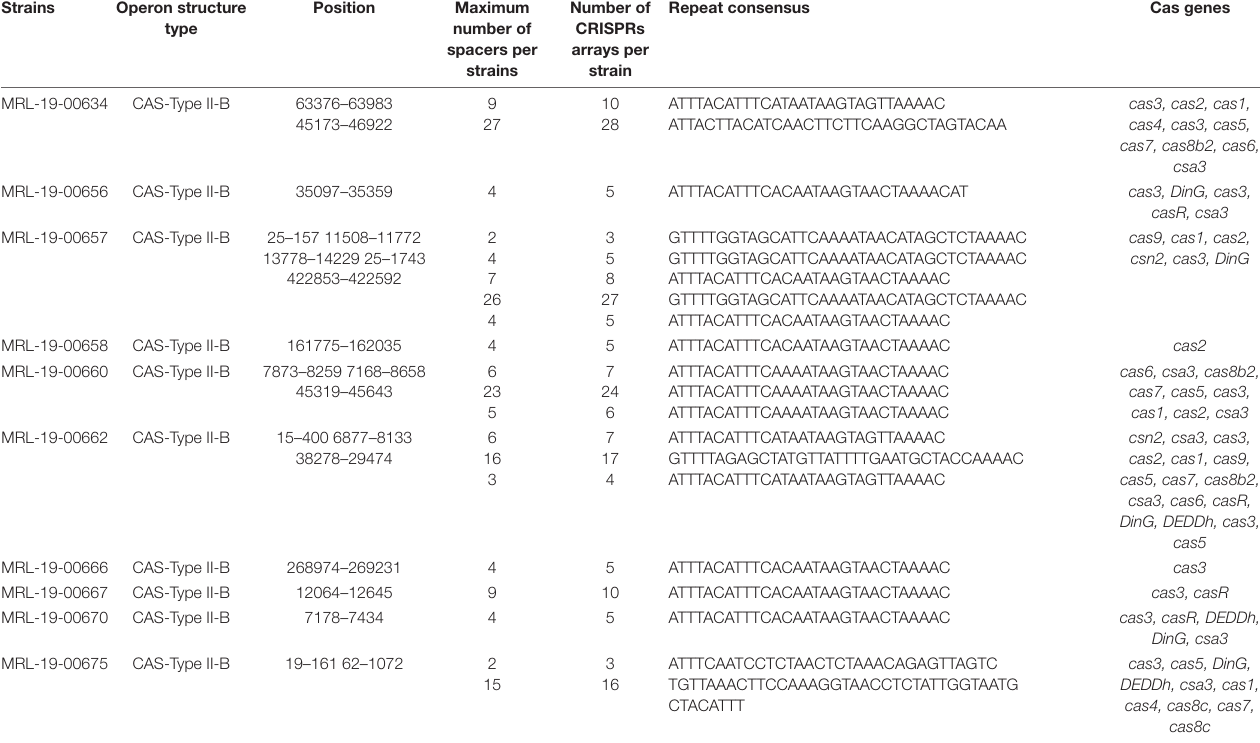
TABLE 5 | CRISPR-Cas systems identified in L. monocytogenes